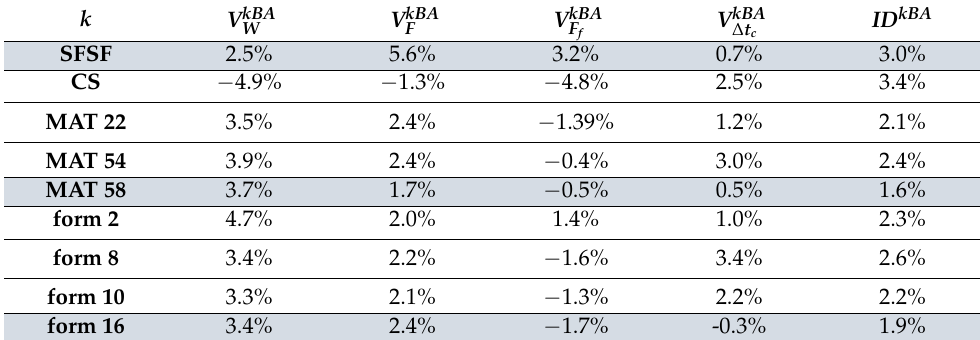
Table 8. Indices for the choice of the numerical setup. Comparison with the evidence.